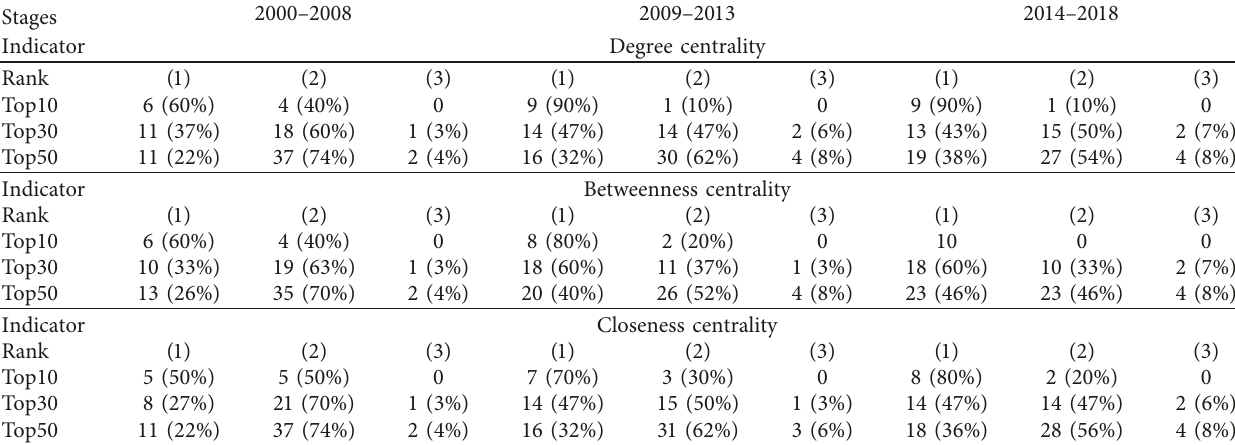
Table 10: Number and proportion of different type of institutions in top 10, 30, and 50 based on centrality analysis. Stages